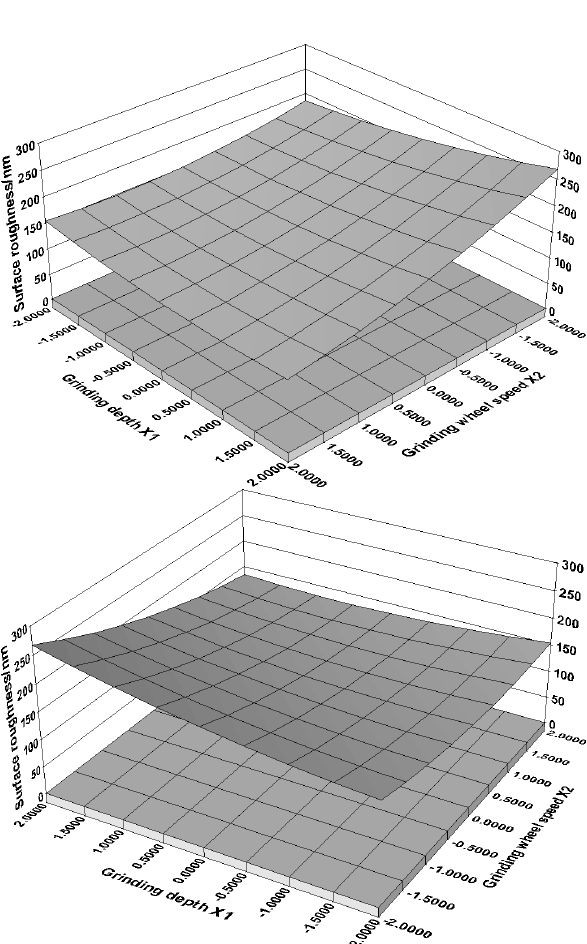
Figure 12: Effect of grinding depth and grinding wheel speed on surface